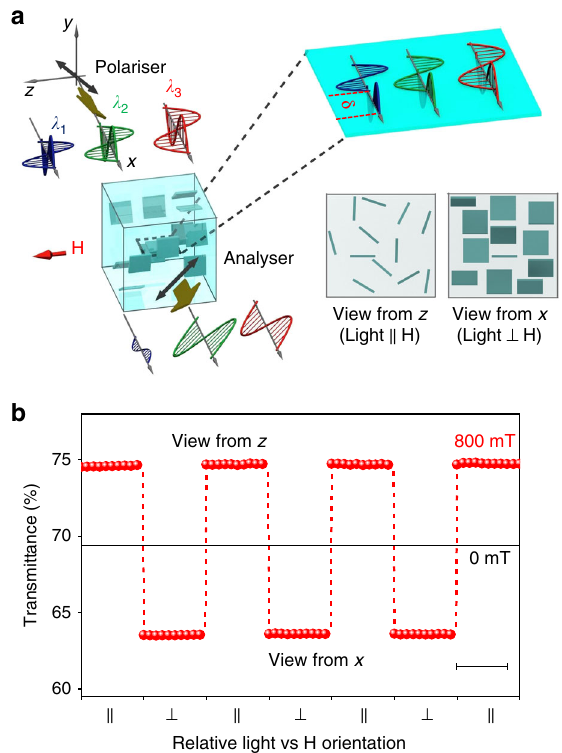
Fig. 2 Alignment of suspended CTO crystals by magnetic fi eld. a Schematic explanation of the colouration effect due to birefringence induced by alignment of 2D crystals (see text). b Transmittance of non- polarised laser light (650 nm) through the CTO suspension in the direction parallel ( ∥ ) and perpendicular ( ⊥ ) to the fi eld of 800 mT (views from z and from x , respectively; see the bottom insets of a ). The fi eld direction was switched between ∥ and ⊥ once per minute. Scale bar, 50 s. The higher light transmission along the fi eld indicates alignment of the 2D crystals parallel to